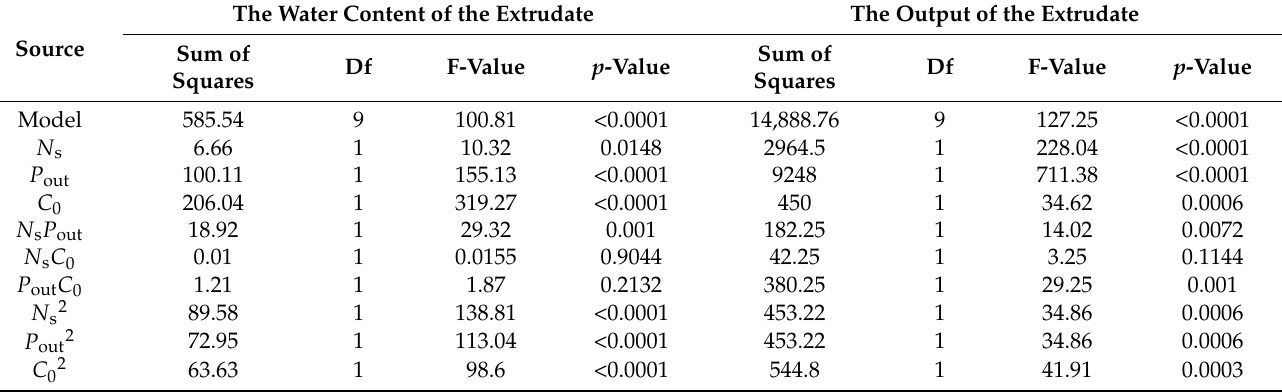
Table 3. Regression equation variance